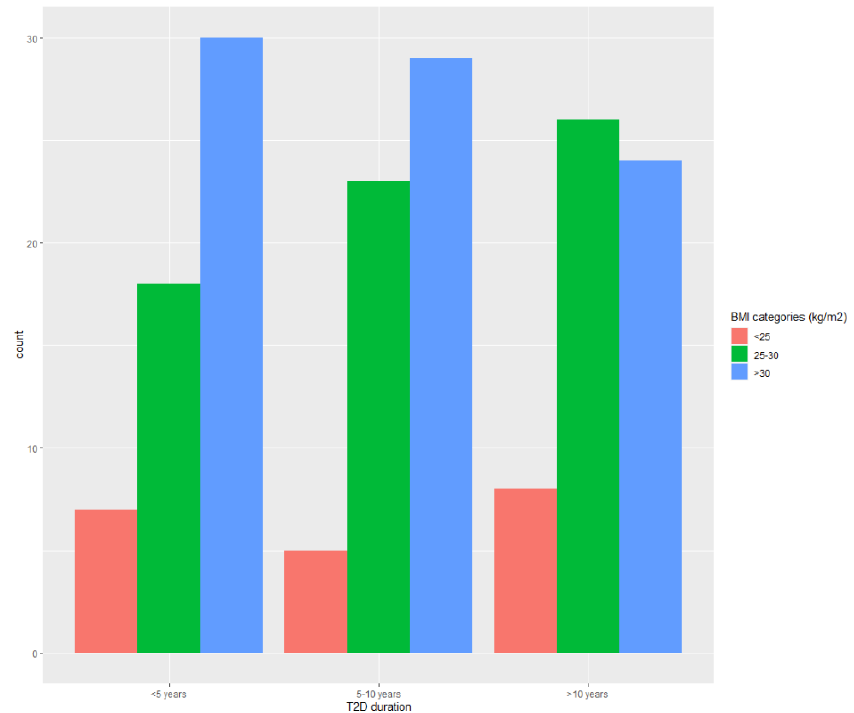
Figure 1. Distribution of patients according to T2D duration and BMI categories.